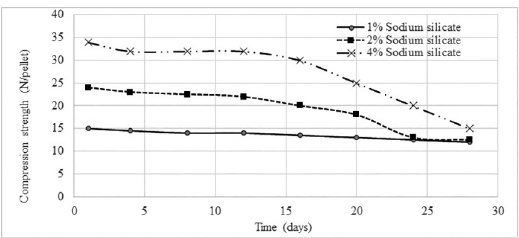
Figure 6: Compression strength of chromite self-reducing pellets (P5, P6 and P7) bound with 1, 2 and 4% sodium silicate.